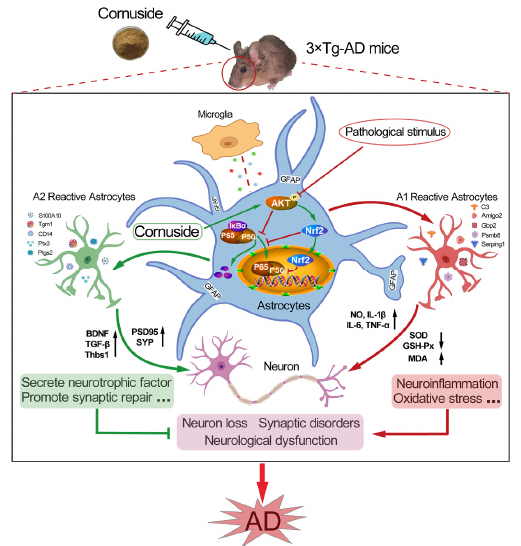
Figure 11. Mechanism of cornuside in improving the cognitive function of the 3 × Tg-AD mice. In the 3 × Tg-AD mice, cornuside regulates the phenotypic conversion of astrocytes, enhances synaptic plasticity, inhibits neuroinflammation and oxidative stress, and ameliorates deficient cognition through the AKT/Nrf2/NF- κ B signaling pathway.